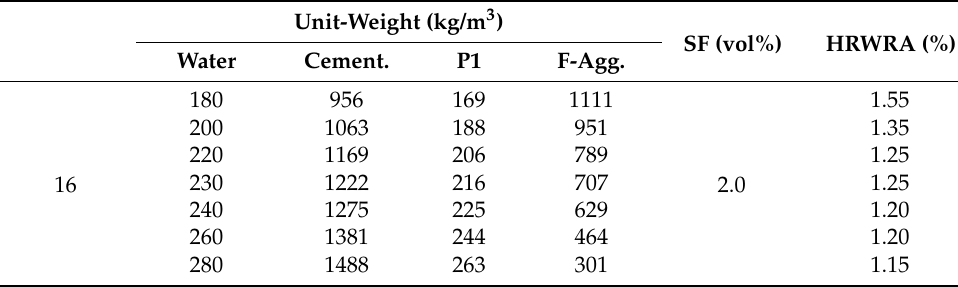
Table 8. Mixture proportions of UHPFRC (a test for the effect of fine